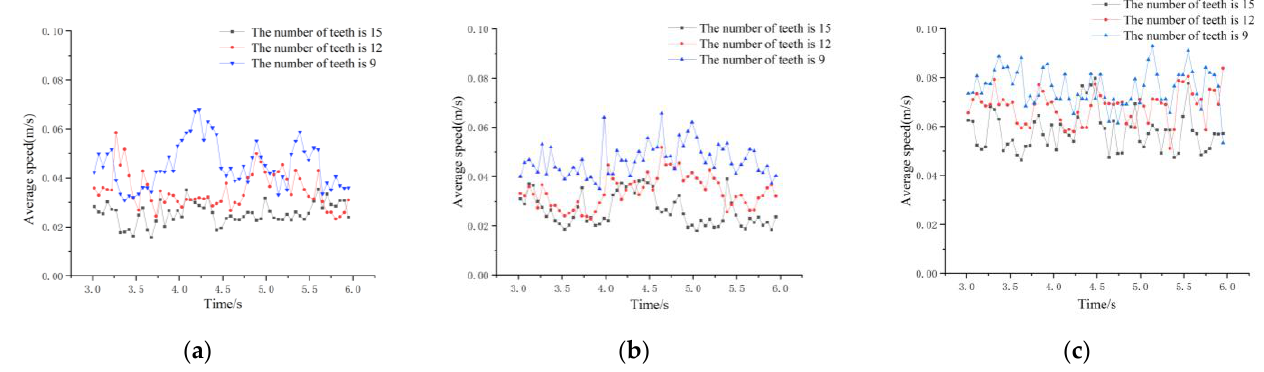
Figure 12. Average velocities of seed plates with different numbers of seeding gear. ( a ) Operating speed 0.5 km/h; ( b ) Operating speed 1 km/h; ( c ) Operating speed 1.5 km/h.